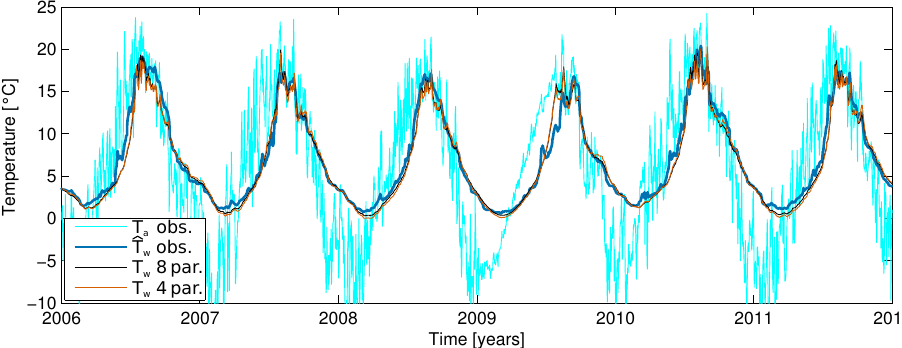
Fig. 9. Comparison between simulated and observed surface water temperature during the calibration period 1994–2005 (GLERL simulation). Fig.9. Comparisonbetweensimulatedandobservedsurfacewatertemperatureduringthecalibrationperiod1994-2005(GLERLsimulation). Simulated curves refer to the full eight-parameter and the simplified four-parameter models. Observed air temperature data are also presented Simulated curves refer to the full 8-parameter and the simplified 4-parameter models, respectively. Observed air temperature data are also with cyan line. presented with cyan line.